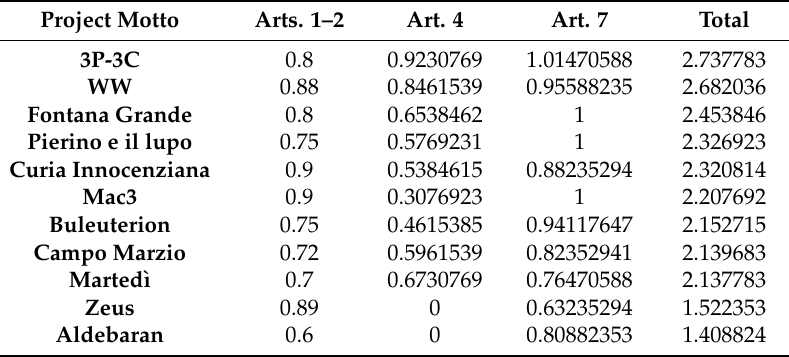
Table 7. Example of quantitative criterion: “relevance to the rules”—total of the partial values (arts. 1, 2, 4 and